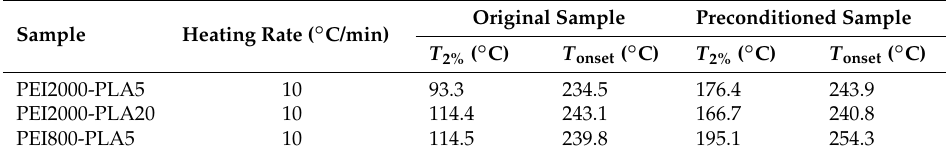
Table 1. Thermogravimetric analysis (TGA) results for the original and isothermally preconditioned samples. Sample